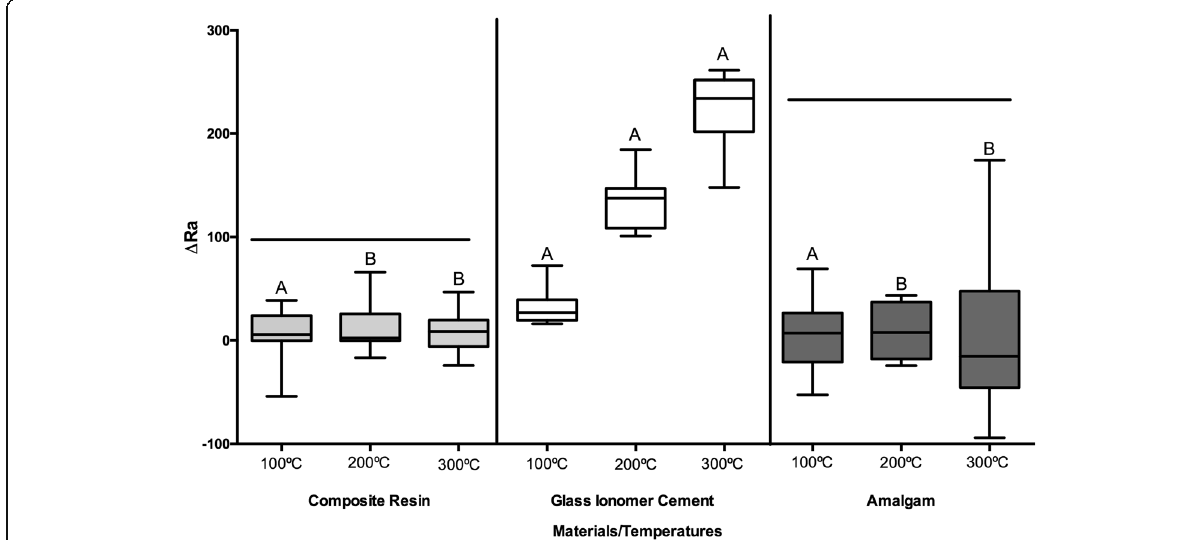
Fig. 4 Graphic representation of the comparison of Δ KHN between the materials when exposed to the heat action (one-way ANOVA, Tukey test, p < .05). The horizontal lines over the bars indicate no statistically significant difference ( p > .05). Different letters indicate significant difference ( p < .05) between the materials at the same temperature